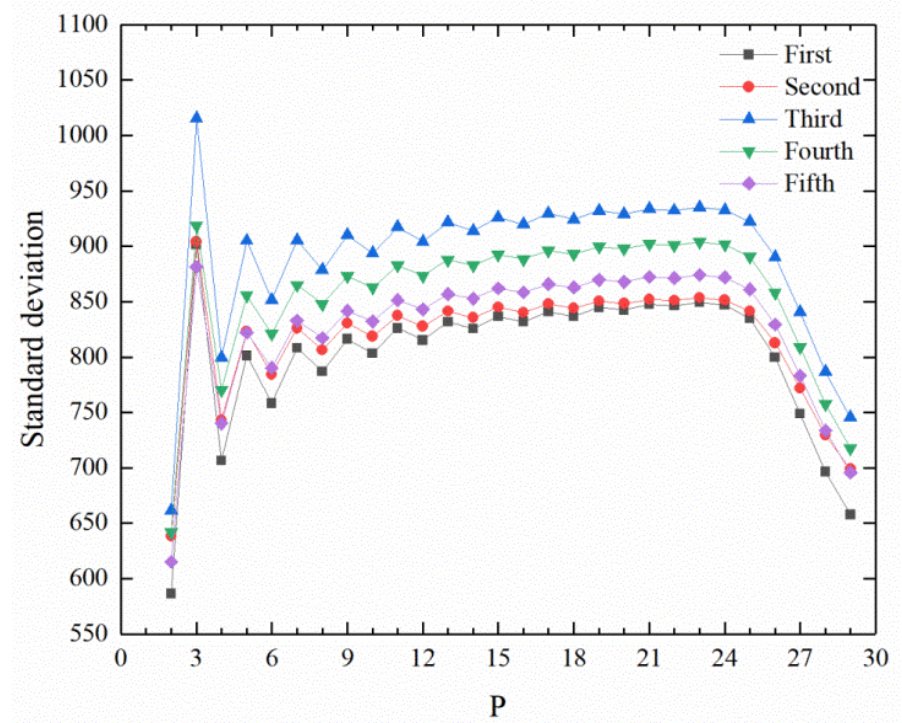
Figure 3. Using the Minkowski distance, the standard deviation of the features was obtained with different p values.